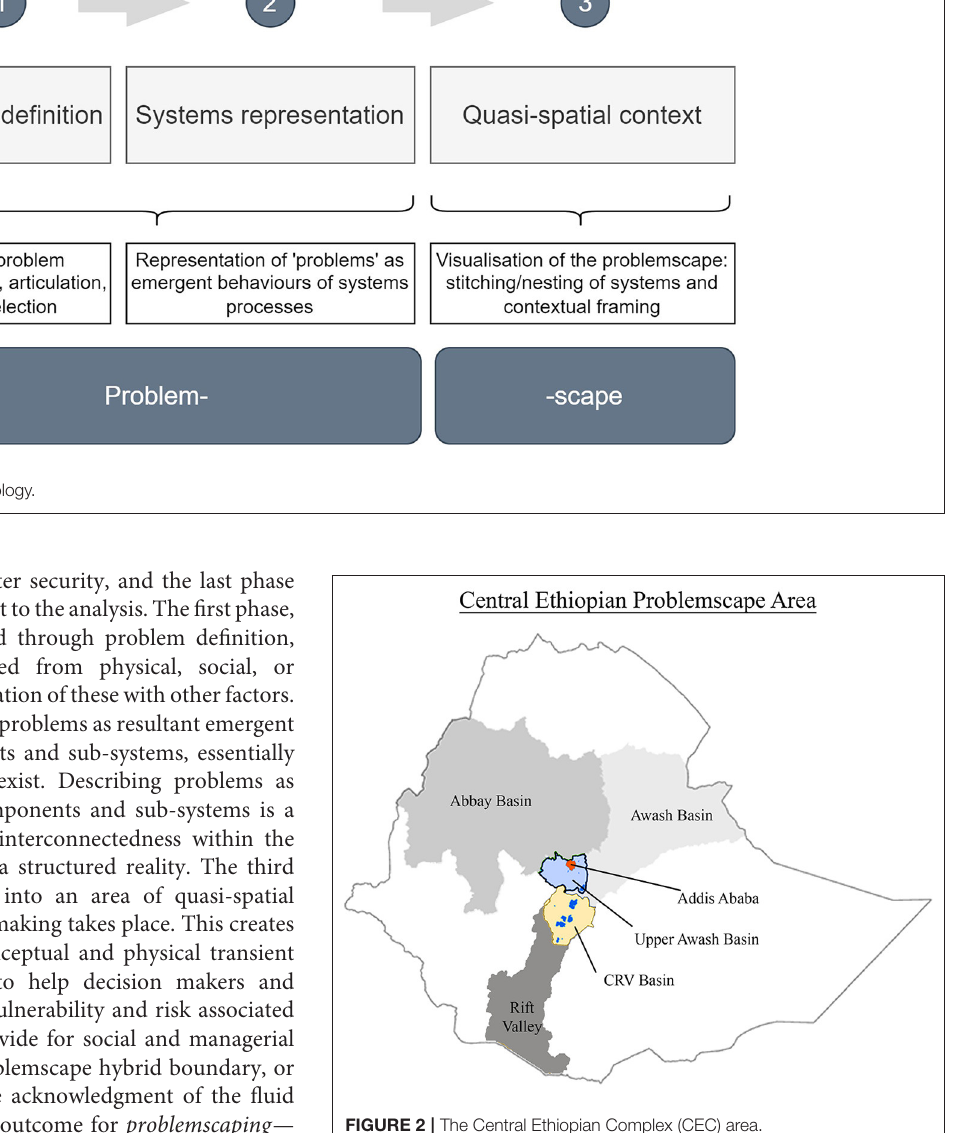
FIGURE 2 | The Central Ethiopian Complex (CEC)